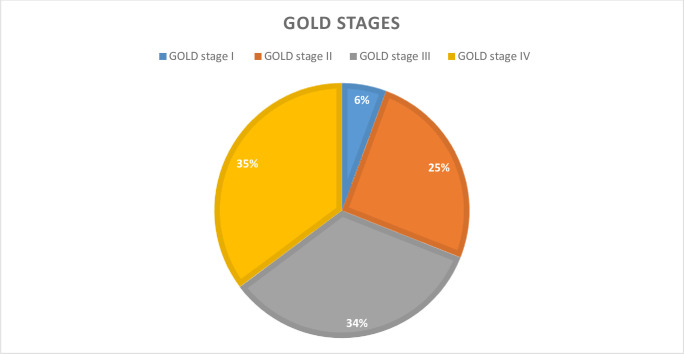
Clinical staging for COPD using GOLD at JMC, April -September, 2019.